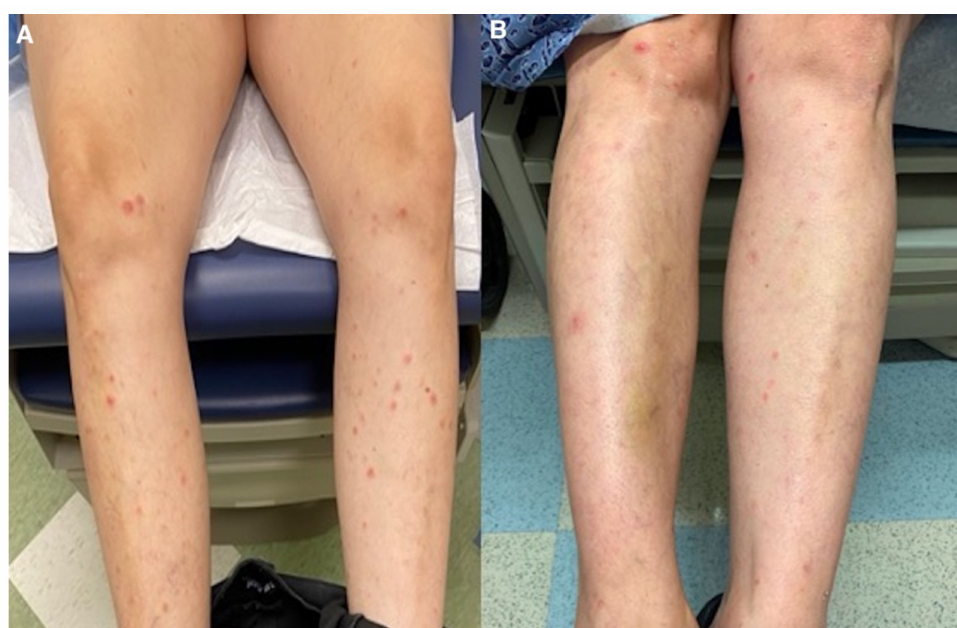
Figure 5. ( A ) Lower extremities before medical management; ( B ) after azithromycin